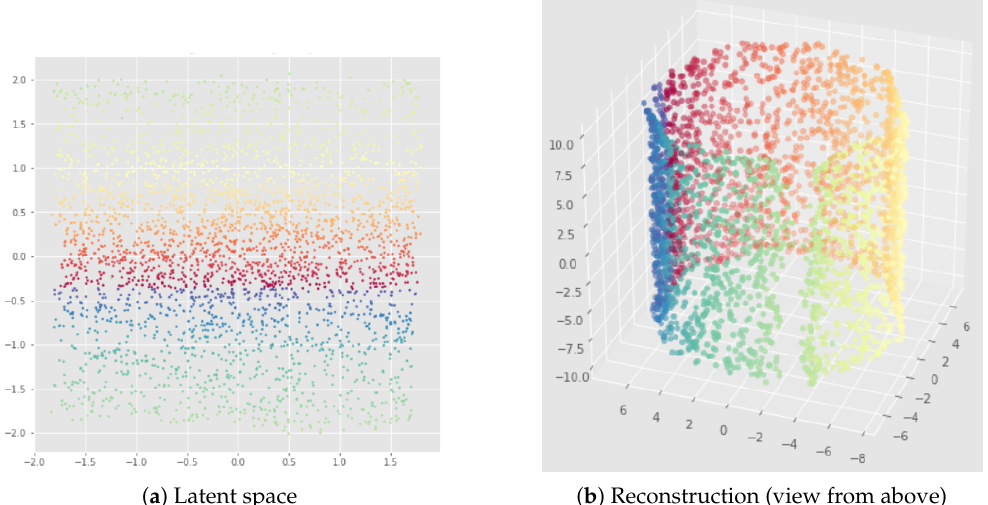
Figure 9. Latent representation (left) and reconstruction (right) of the Standard VAE applied to the open cylinder-pytorchseed = 6, trained for 500 epochs. In this case, we can see that for the latent representation ( a ) we have β 1 = 0 instead of 1. This means for example that from the latent representation we would not know that it is actually possible to go from the yellow part to the blue part without passing through the red part, because in this bad latent representation there is a discontinuity in the green region. In addition to that, the discontinuity in the green region of the latent space ( a ) implies a discontinuity in the green region of the reconstructed cylinder ( b ) so the reconstruction is also bad.